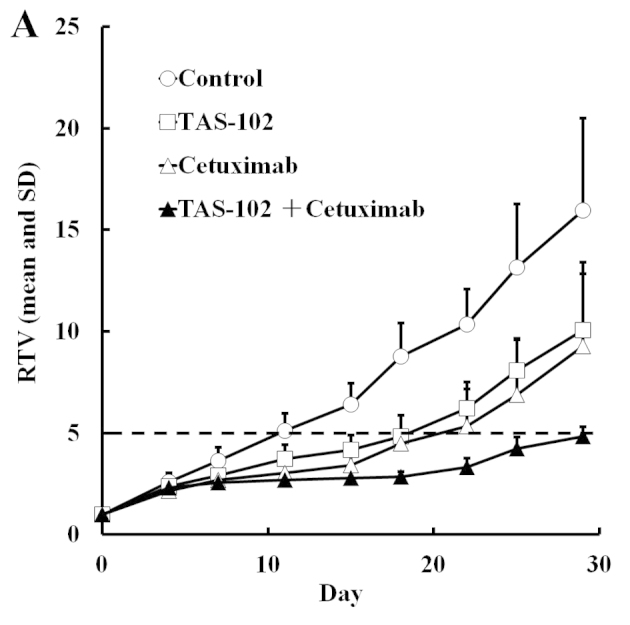
Relative volume change in human SW48 colorectal tumors (A) and body weight change in SW48 tumor-bearing nude mice (B). Mice were treated with vehicle (○), TAS-102 (□), cetuximab (△), or combined TAS-102 and cetuximab (▲). The values indicate the means + SD (n=6). The horizontal dotted line indicates an RTV of 5. RTV, relative tumor volume.